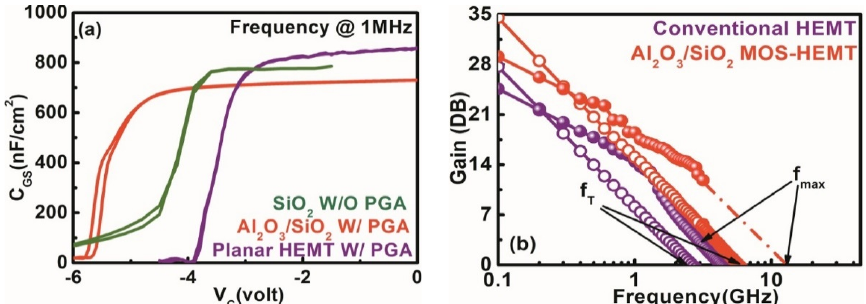
Figure 13. ( a ) Capacitance voltage characteristics of the conventional HEMT and the Al 2 O 3 /SiO 2 MOS–HEMT with gate annealing treatment and SiO 2 MOS–HEMT without PGA treatment. ( b ) High-frequency characteristics of stack layer MOS–HEMT and conventional HEMT. Table 1. Comparison of DC/RF performances for different gate structure AlGaN/GaN MOS-HEMTs with dual surface treated Al 2 O 3 /SiO 2 stack layer MOS-HEMT.